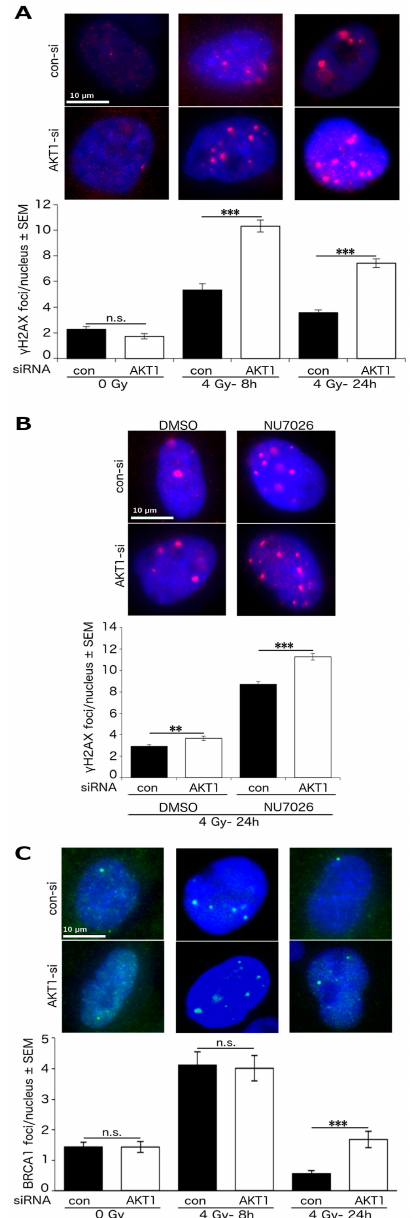
Figure 3. Akt1 promotes DSB repair after irradiation partially by stimulation of HR repair. A549 cells were transfected with AKT1-siRNA or con-siRNA. ( A ) The number of γ H2AX foci was analyzed at the indicated time points post irradiation. The results at 8 h after irradiation represent the mean ± SEM of 2 independent experiments and a total of at least 158 evaluated nuclei per condition. The data for the non-irradiated cells and the cells at 24 h post irradiation are based on the mean ± SEM of 3 independent experiments and a total of at least 275 nuclei per condition. The number of γ H2AX foci/nucleus was significantly increased after Akt1-KD (*** p < 0.001, Student’s t -test); ( B ) following treatment with the DNA-PKcs inhibitor NU7026 (10 µ M) and irradiation, γ H2AX foci assay was performed. The data represent the mean ± SEM of 3 independent experiments and a total of at least 320 evaluated nuclei per condition. Akt1-KD significantly increased the number of residual γ H2AX foci/nucleus (** p < 0.01, *** p < 0.001, Student’s t -test); ( C ) the number of BRCA1 foci was determined at the indicated time points after irradiation. The results are based on the mean ± SEM of 3 independent experiments and a total of at least 287 nuclei per condition. Asterisks indicate a significant increase in the number of residual BRCA1 foci/nucleus following Akt1-KD (*** p < 0.001, Student’s t